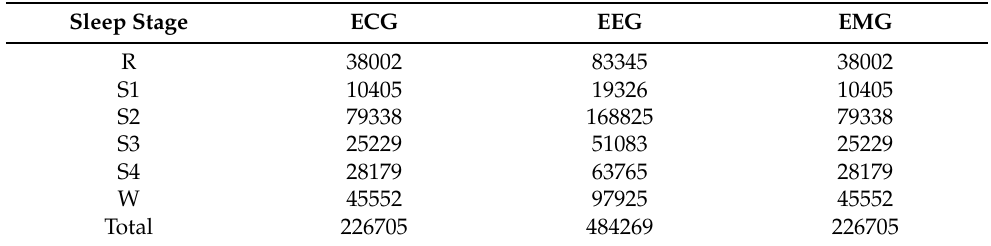
Table 1. Number of spectrogram images calculated for six sleep stages (W: wake, S1–S4: sleep sub-stages, and R: rapid eye movement), and three modalities (ECG, EEG, and